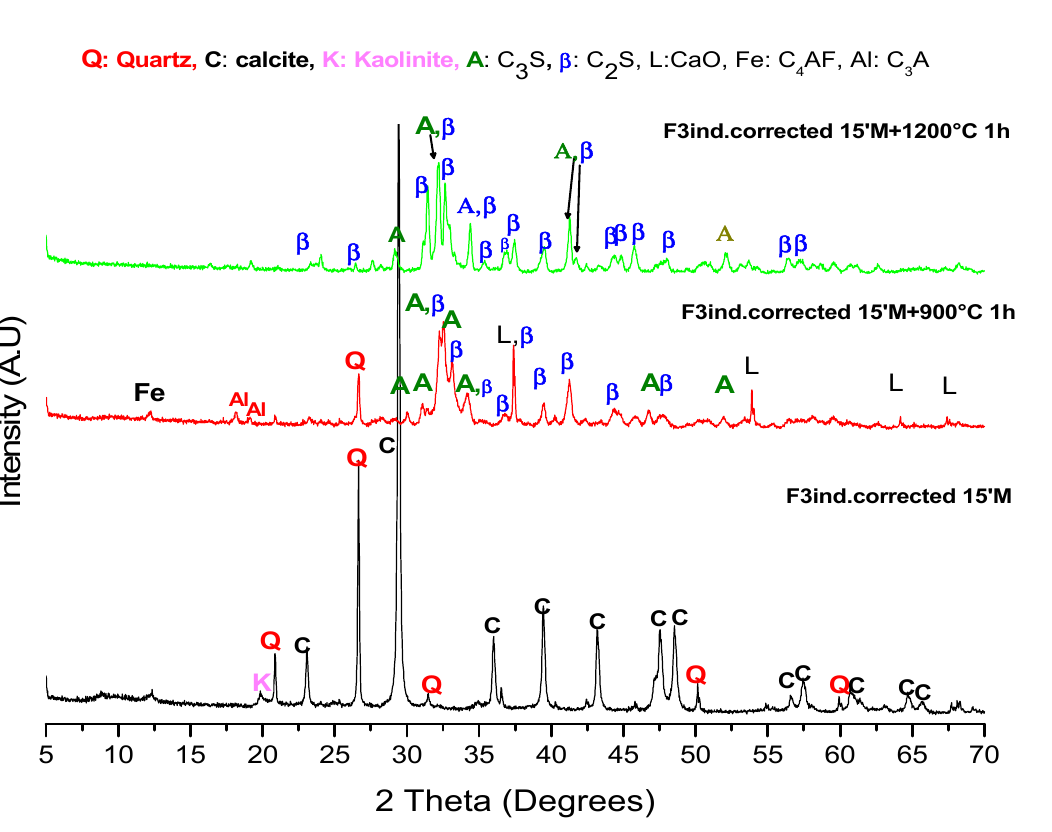
Figure 5. Diffraction patterns of the milled premix F2ind. and F3ind. corrected and the clinkers pro- duced by indirect mechanosynthesis.